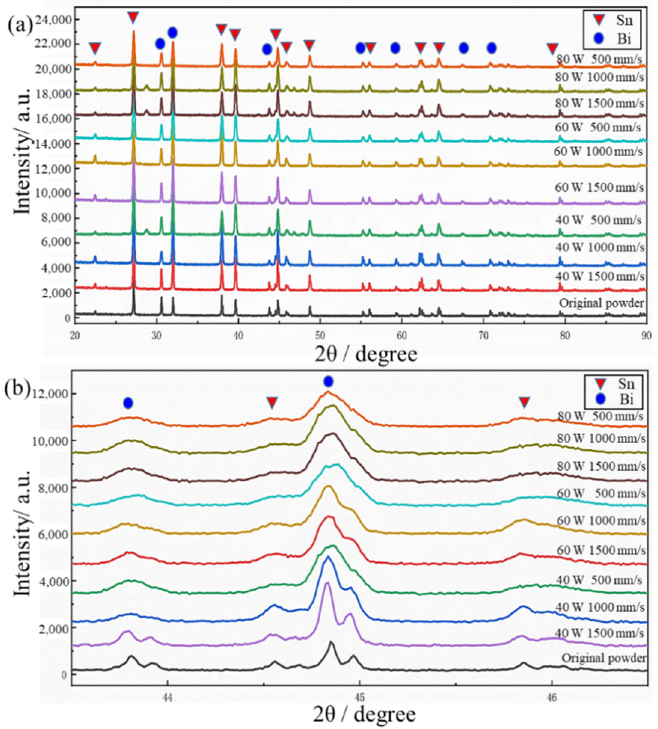
Figure 8. XRD patterns of the as-printed Sn58Bi alloy and Sn58Bi alloy powder: ( a ) 20–90° diffraction angle, ( b ) 43–47° diffraction angle.